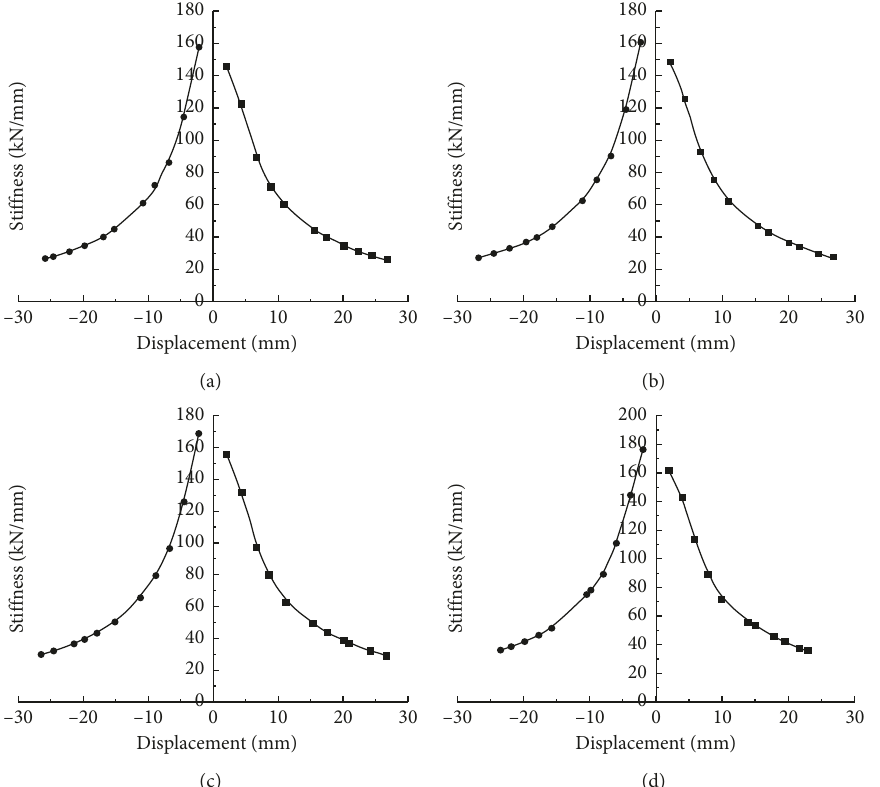
Figure 15: Stiffness degradation curves of frames with various reinforcement ratios. (a) K-5. (b) K-6. (c) K-1. (d)